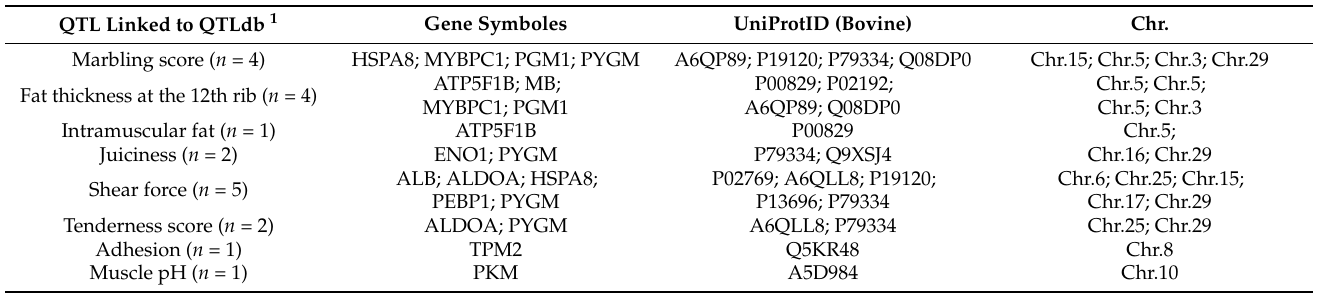
Table 4. List of the Quantitative trait loci (QTL) of carcass and meat quality traits and their chro- mosomes (Chr.) obtained using the list of the proteins from immunocastrated F1 Nellore-Montana young heifers and steers feedlot